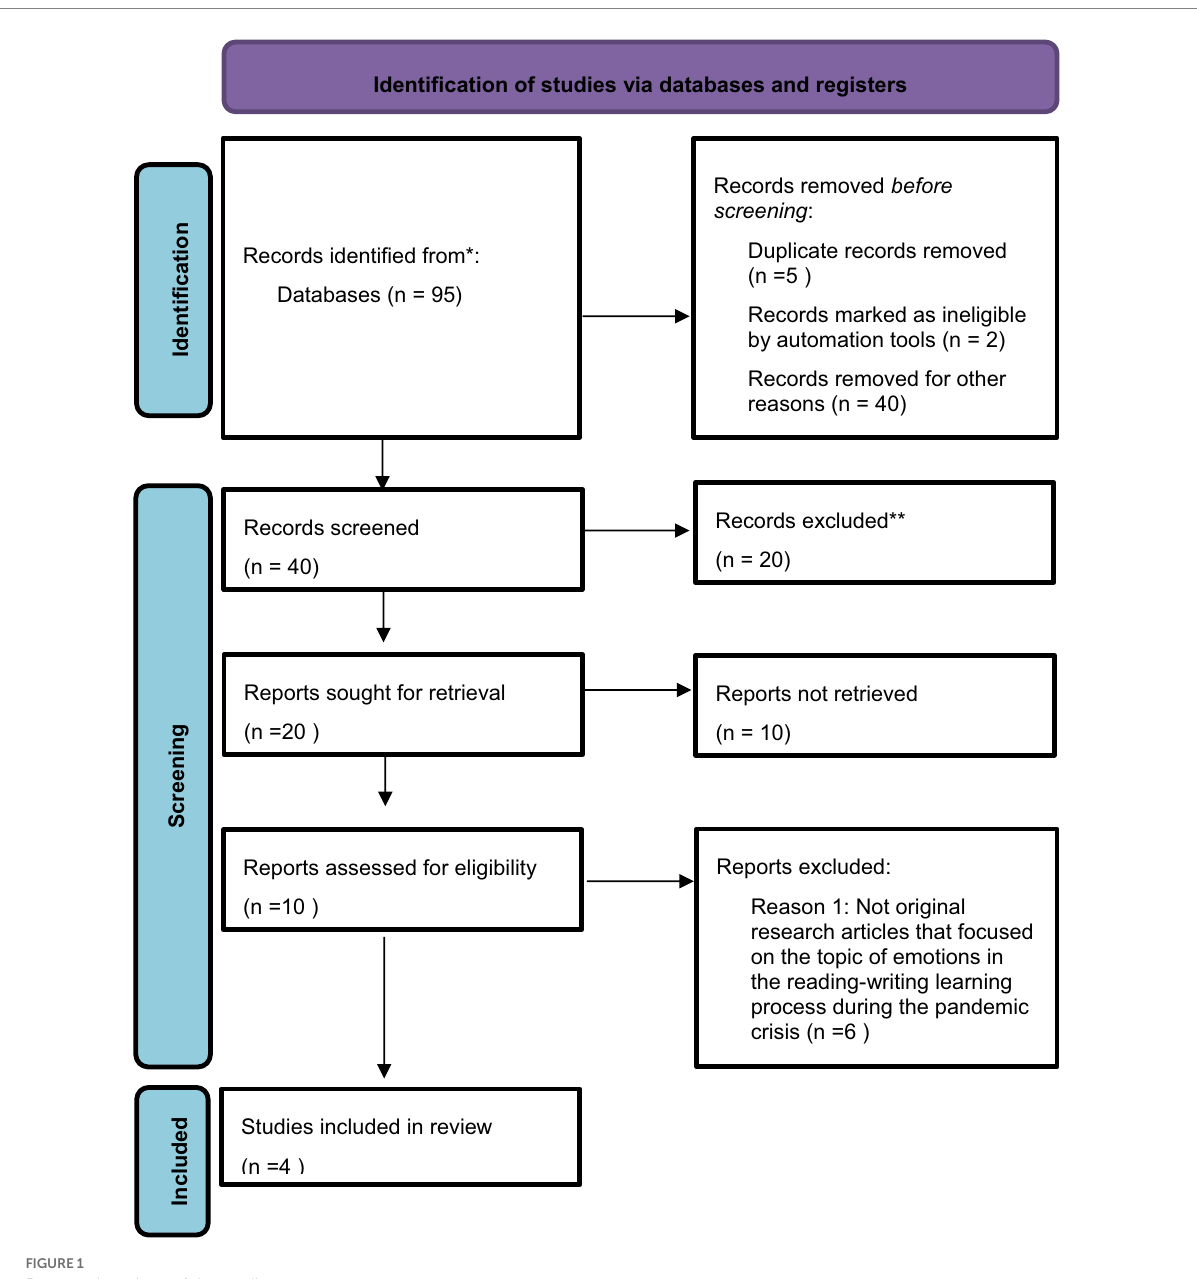
FIGURE 1 Decantation chart of the